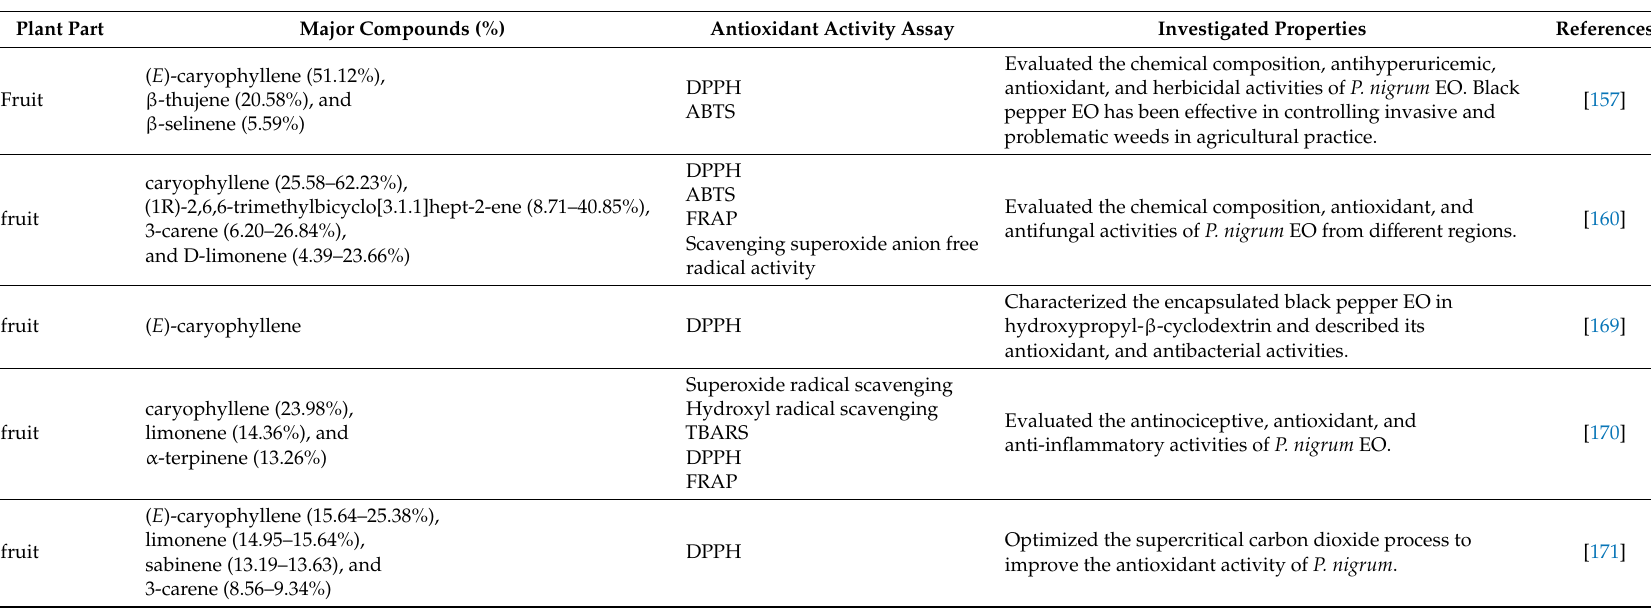
Table 5. Major natural compounds, methodologies applied to determine the antioxidant activity, and the investigated applications of Piper nigrum (Piperaceae) EOs. Plant Part Fruit